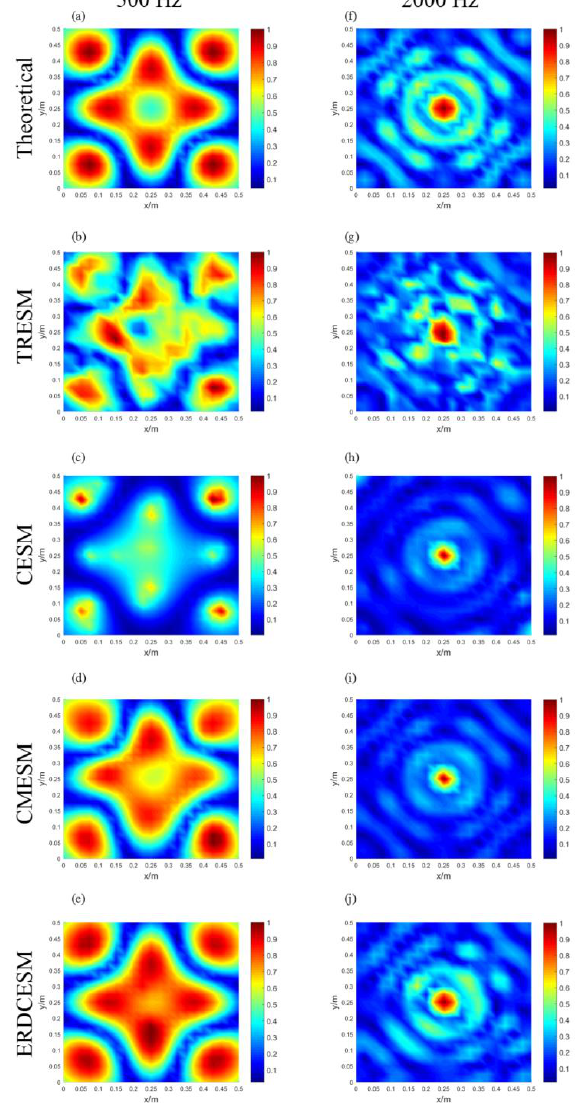
Figure 7. The calculated sound maps of ( a ) Theoretical map at 500 Hz, ( b ) TRESM map at 500 Hz, ( c ) CESM map at 500 Hz, ( d ) CMESM map at 500 Hz, ( e ) ERDCESM map at 500 Hz, ( f ) Theoretical map at 2000 Hz, ( g ) TRESM map at 2000 Hz, ( h ) CESM map at 2000 Hz, ( i ) CMESM map at 2000 Hz and ( j ) ERDCESM map at 2000 Hz for a simply supported